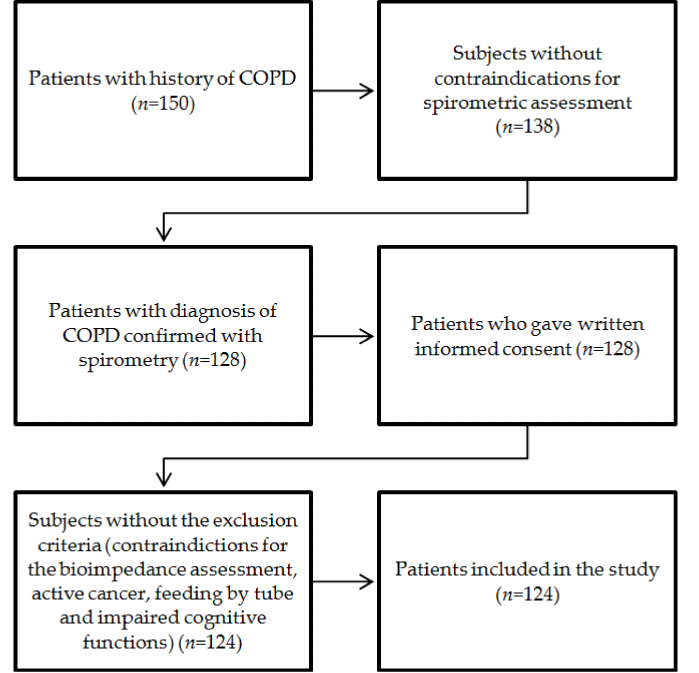
Figure 1. The process of selection and recruitment of patients. Notes: COPD, chronic obstructive pulmonary